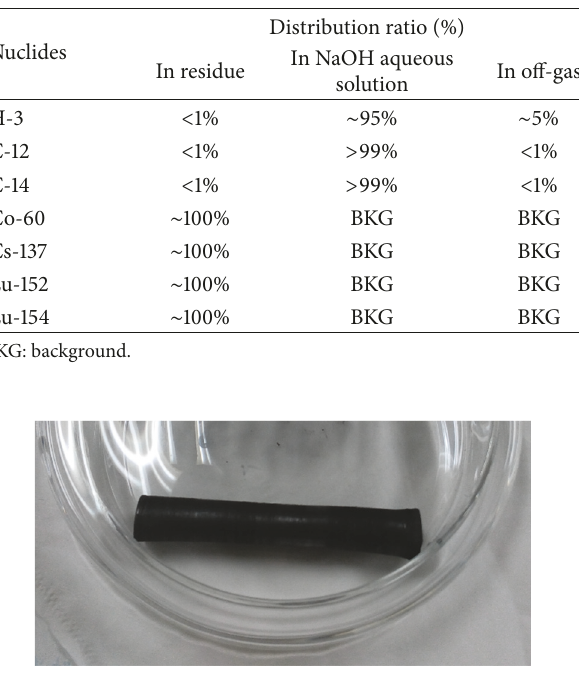
Figure 2: The experimental program on source term analysis of an irradiated graphite sphere.